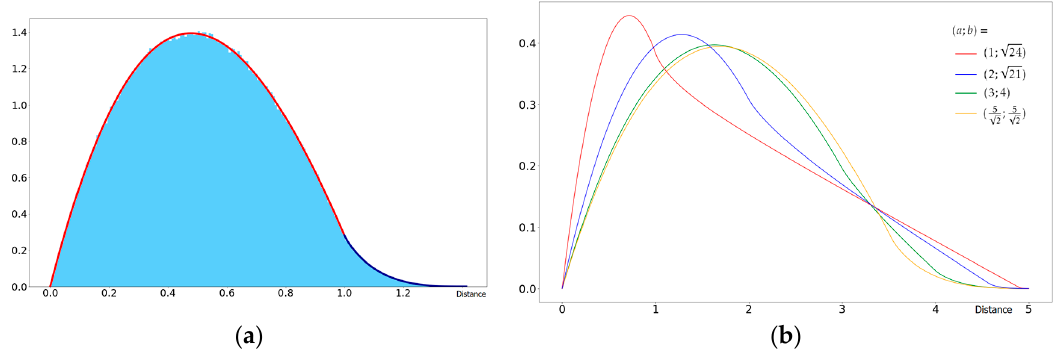
(cid:112) a 2 + b 2 = 5 (this condition